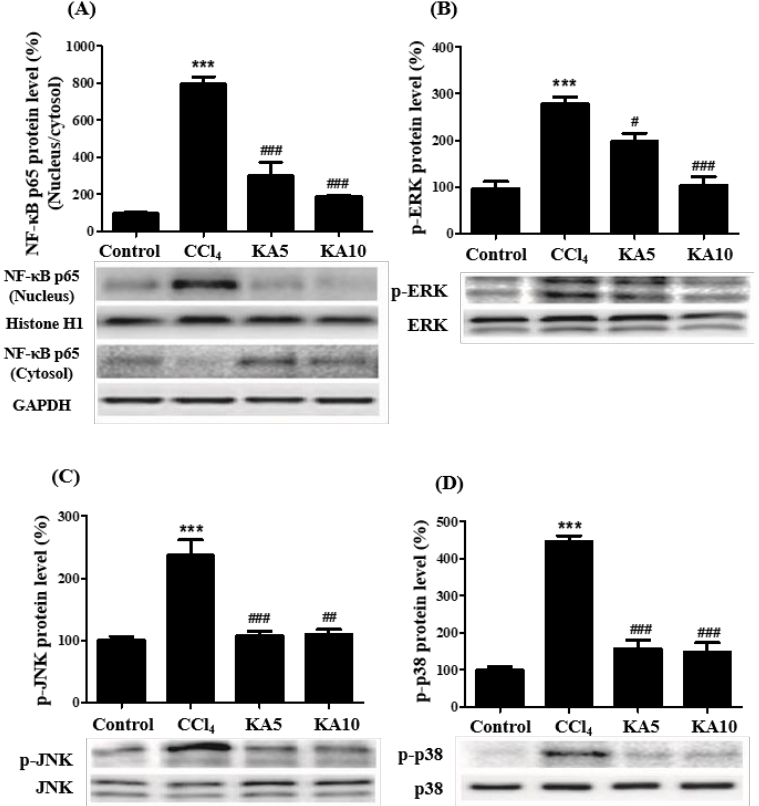
Figure 6. Effects of kaempferol on CCl 4 -induced NF-κB p65 activation ( A ) and ERK ( B ), JNK ( C ), and p-38 ( D ) phosphorylation. Western blotting was performed to detect the relative level of NF-κB p65 in the nuclear and cytosol and phosphorylated ERK, JNK, and p-38. Histone H1, GAPDH, and total ERK, JNK, and p-38 were used as loading controls, respectively. Values are mean ± SE ( n = 3). *** p < 0.001 vs. the control group, and # p < 0.05, ## p < 0.01, and ### p < 0.001 vs. the CCl 4 group.